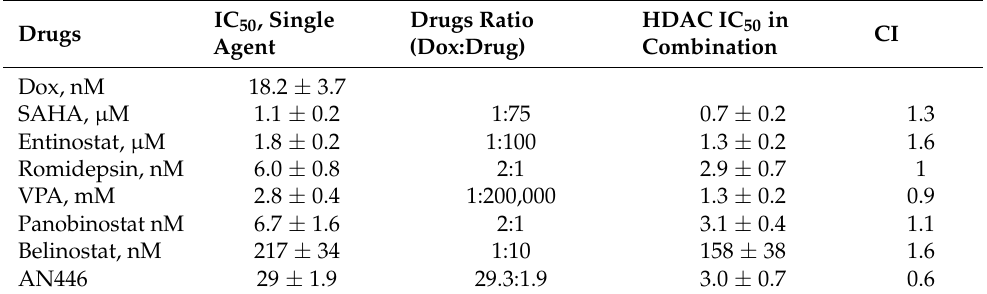
Table 1. Values of IC 50 for each of the indicated drug as a single agent and in combination with Dox.